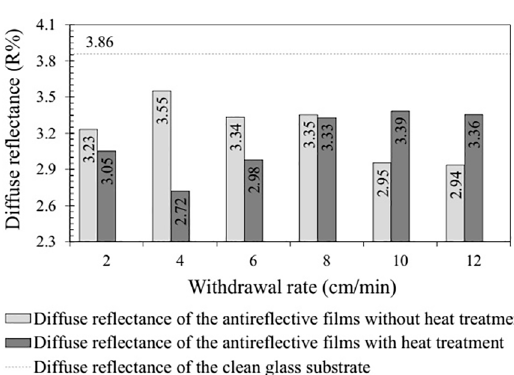
Figure 3. Average diffuse reflectance of the clean glass substrate and antireflective films at different withdrawal rates rates around 4 cm/min result in films with refractive